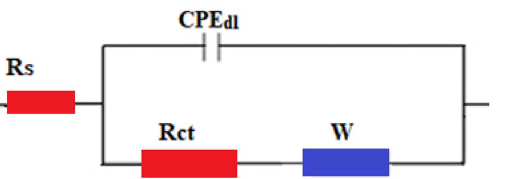
Figure 17. The equivalent circuit